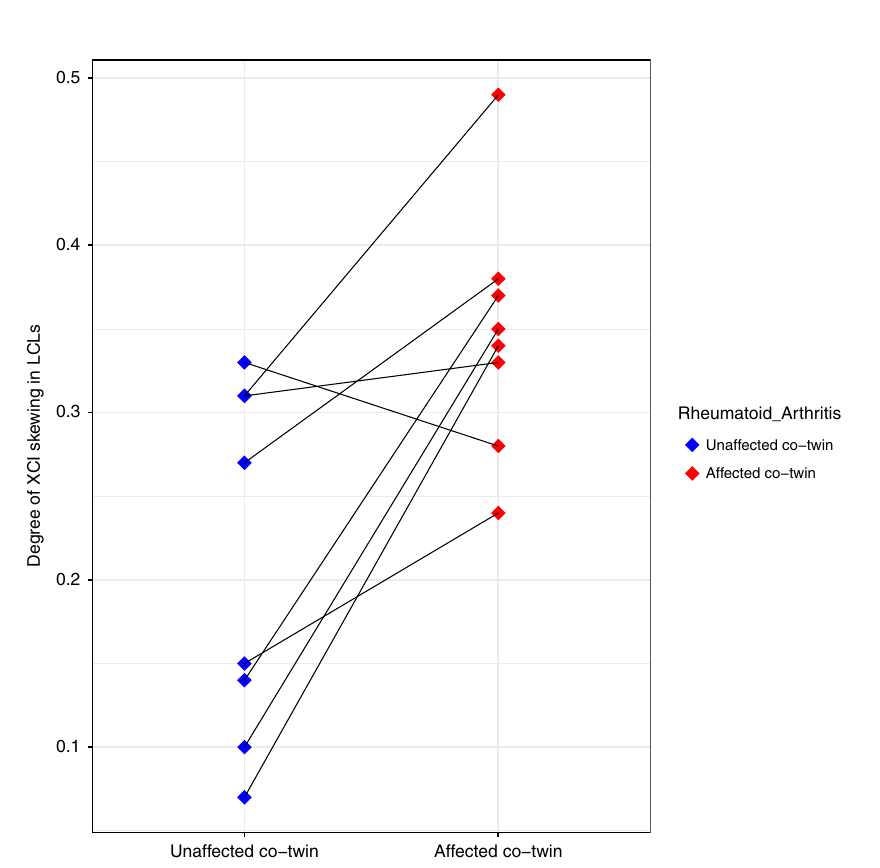
Fig. 5 XCI patterns are more skewed in blood-derived tissues of individuals affected with rheumatoid arthritis than in their unaffected identical co-twins. Dotplot shows the degree of XCI skewing in LCLs from monozygotic twin pairs that are discordant for rheumatoid arthritis ( n = 8 twin pairs). Blue dots on the left represent the twin without rheumatoid arthritis and red dots the co-twins diagnosed with rheumatoid arthritis. Co-twins are connected by a line. XCI